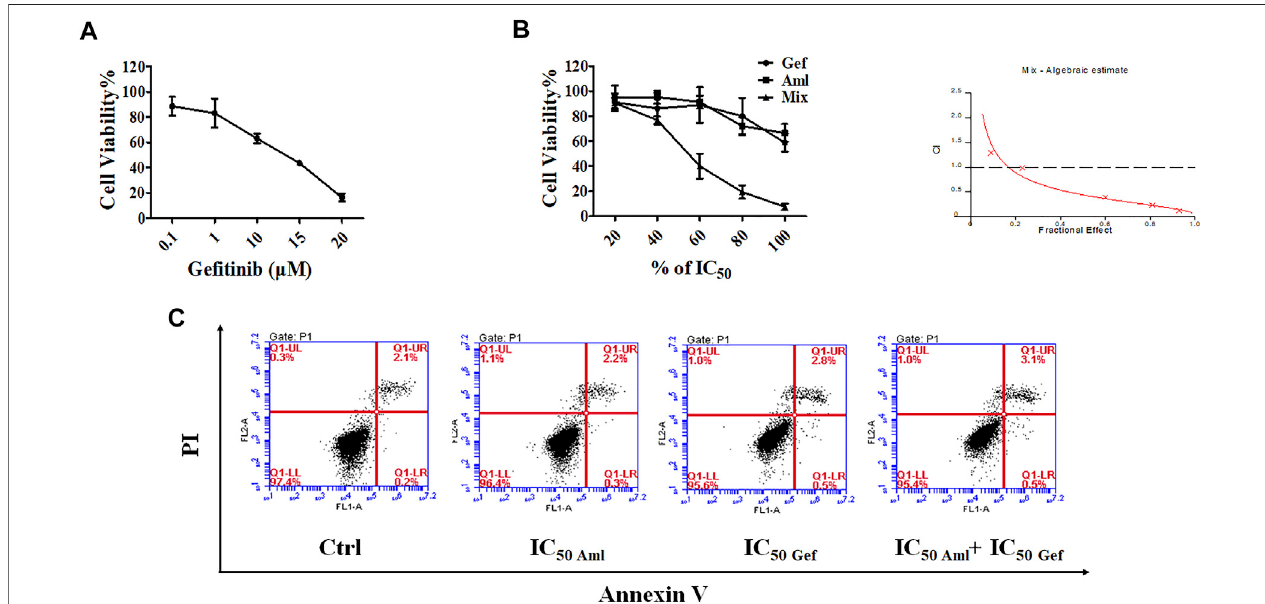
FIGURE 3 | Amlodipine combined with ge fi tinib led to a synergistic anti-proliferative effect on A549 cells. (A) MTT assay was used to detect the inhibitory effect of ge fi tinib (Gef) on cell proliferation. (B) A549 cells were treated with amlodipine, ge fi tinib, or a combination of these agents for 48 h. A549 cells were treated with amlodipine and ge fi tinib, with several percentages of IC 50 value. (C) A549 cells were harvested 48 h after treatment with amlodipine, ge fi tinib, or a combination of these agents, and apoptotic cells were examined by fl ow cytometry